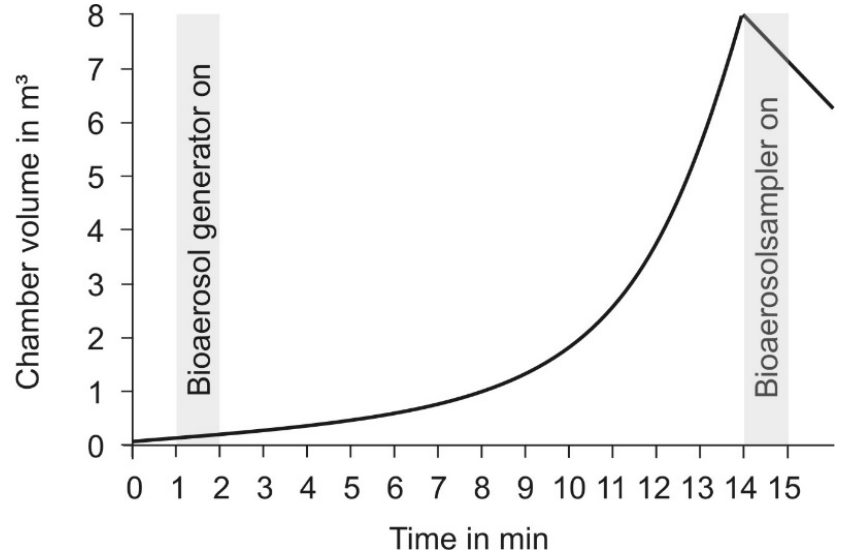
Figure 2. Schematic representation of the test procedure as a function of the chamber volume and the test time.